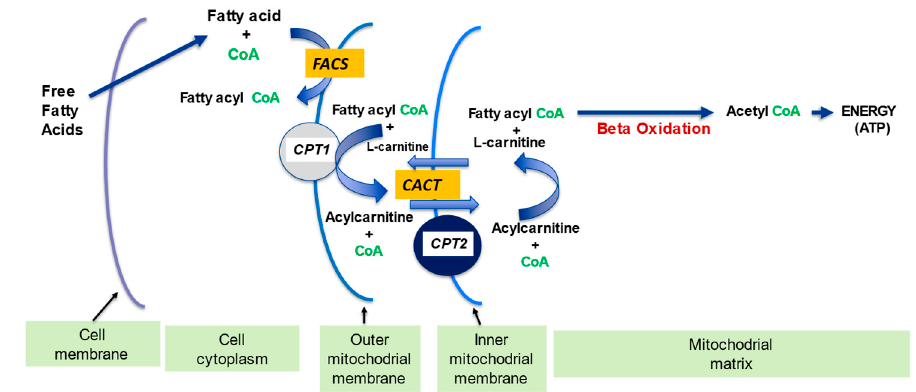
Figure 2. The Role of L-carnitine in fatty acid transport and β -oxidation in mitochondria.